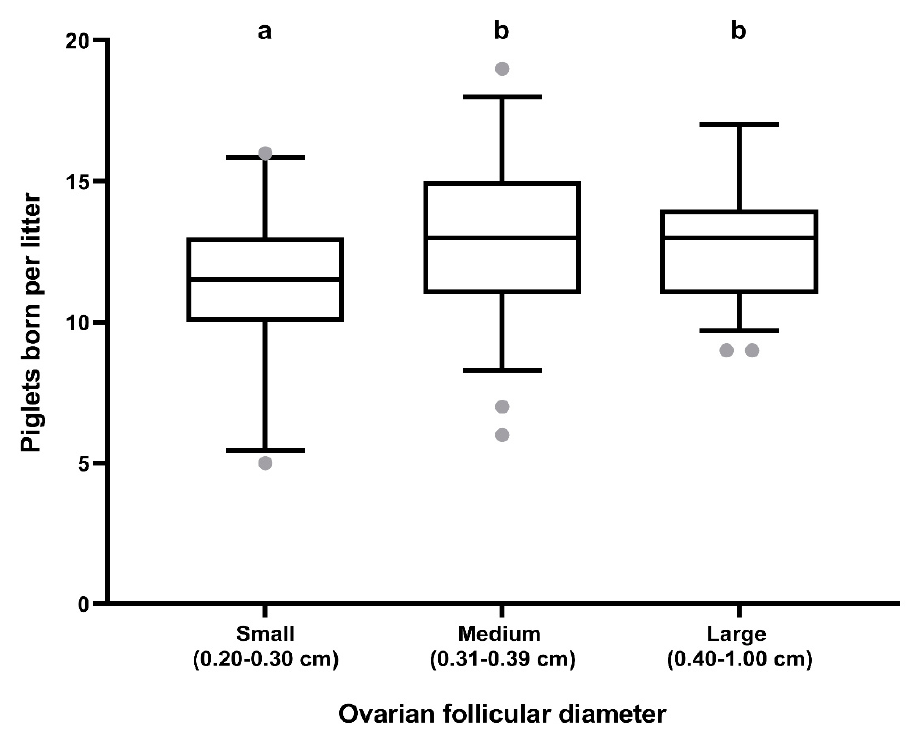
Figure 3. Box–whisker plots showing differences in the number of piglets born per litter among sows hierarchically grouped according to the mean ovarian follicle diameter at weaning: Small (0.20–0.30 cm), medium (0.31–0.39 cm), or large (0.40–1.00 cm) ovarian follicles at weaning. Boxes enclose the 25th and 75th percentiles; the line is the median; and the whiskers extend to the 5th and 95th percentiles. Grey dots show outliers. a and b indicate significant differences ( p < 0.05).